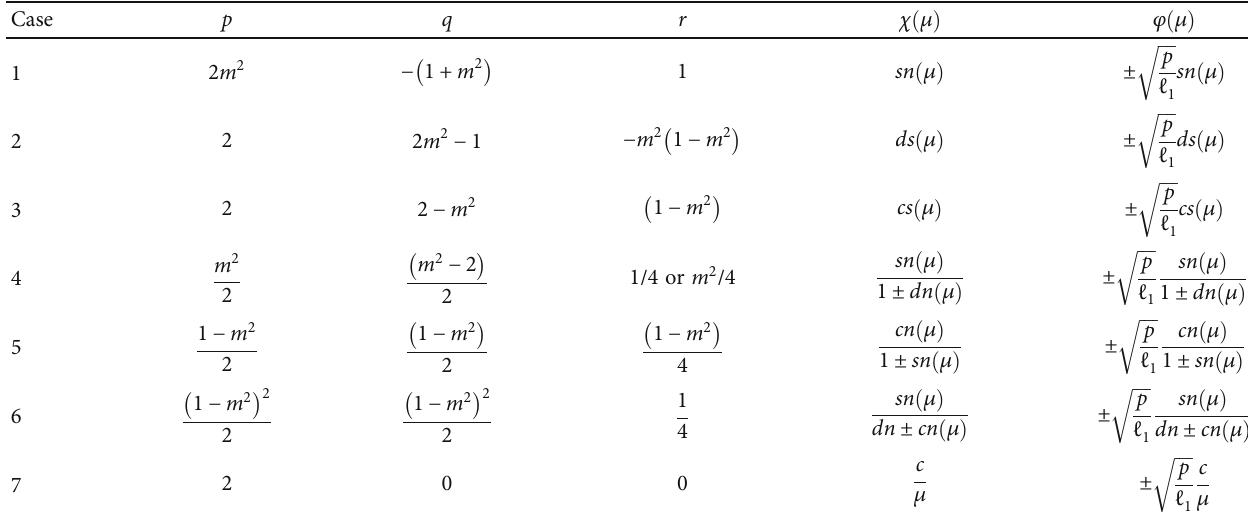
Table 2: All possible solutions for wave Equation (14) when p > 0